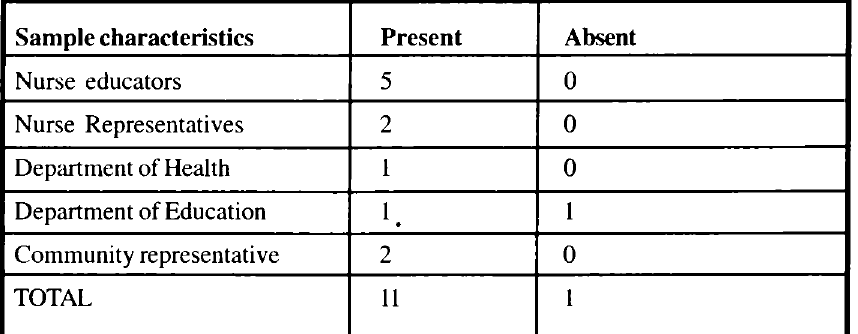
Tablel: The Education Committee’s